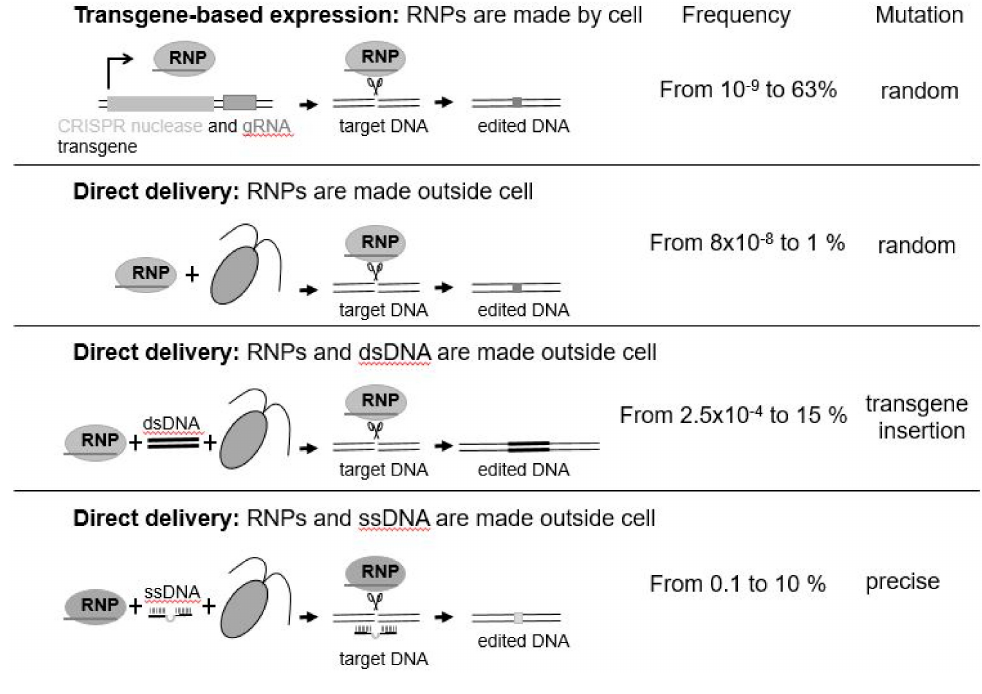
Figure 1. Gene editing approaches in microalgae. Relative frequency range of successful mutations reported from each approach are provided. RNP = ribonucleoprotein; gRNA = guideRNA; dsDNA = double-stranded DNA; ssDNA = single-stranded DNA. Transgene-based expression [31–33,38]; Direct delivery, RNPs made outside cell [34,35]; Direct delivery, RNPs and dsDNA made outside cell [36]; Direct